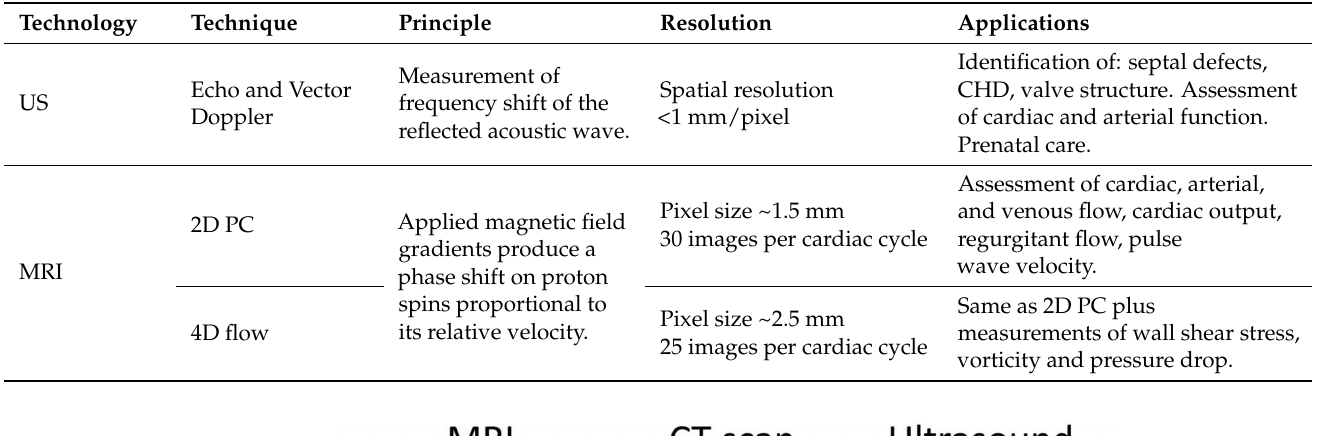
Table 5. Image-based technique for assessment of blood flow.